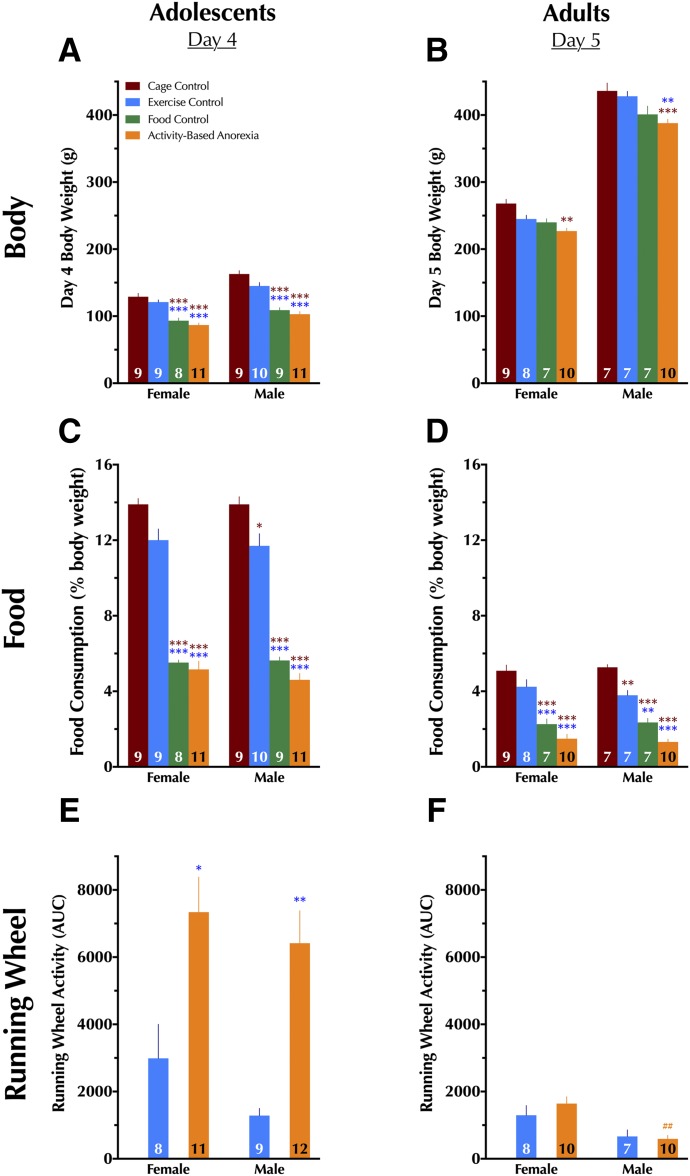
Final day body weight, food consumption, and running wheel measures in drug-naive rats. The final day in the experimental paradigm for adolescents was day 4, whereas the final day for adults was day 5. Because animals used for chronoamperometry and cocaine-induced locomotion were removed prior to completion of their full fourth (adolescents) or fifth (adults) day, only data from drug-naive rats are shown here. (A) Adolescent day 4 body weight; (B) adult day 5 body weight; (C) adolescent and (D) adult food consumption over the past 23 hours as a percentage of the individual animal’s body weight; (E) adolescent and (F) adult running wheel activity over the last 23 hours for EC and ABA animals. No running wheel activity is shown for CC and FC animals because their wheels were locked and therefore they could not run in the wheel. Data were analyzed within each age group with a two-way (sex × condition) ANOVA with Tukey-Kramer’s post-hoc tests where appropriate. Data are graphed as mean + S.E.M. *P < 0.05; **P < 0.01; ***P < 0.001 vs. same-sex condition, indicated by color of asterisk(s), within the same age group. ##P < 0.01 vs. same condition in females of same age group. Number of animals is indicated at base of each bar.